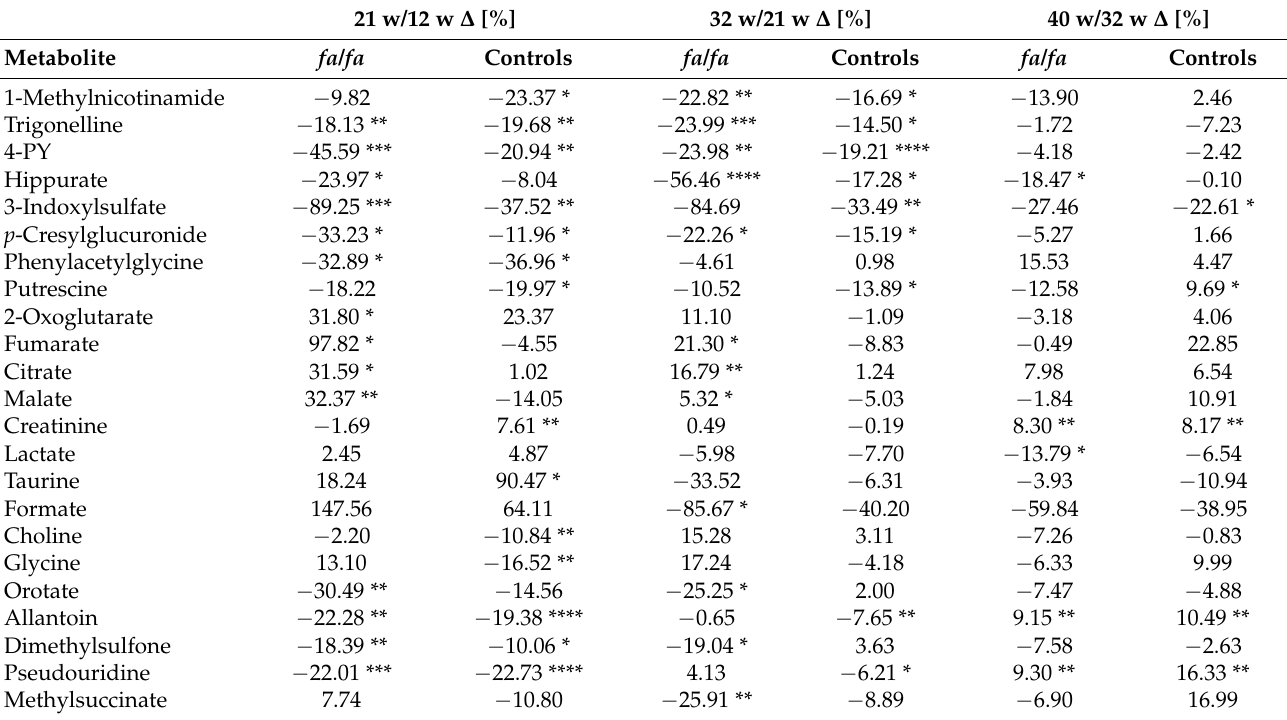
Table 3. Significantly changed metabolites in the urine of fa / fa and control rats during